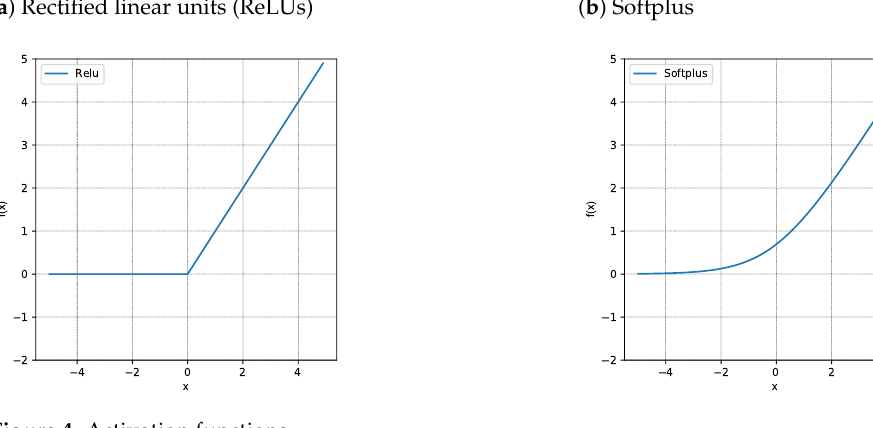
Figure 4. Activation